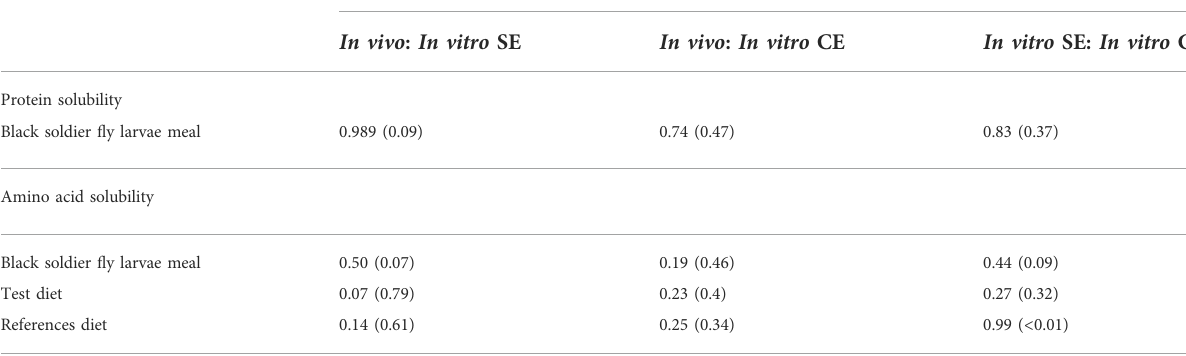
TABLE 5 Correlation between In vivo , and in vitro protein and amino acid solubility of black soldier fl y (BSF) larvae meal, test diet and reference diet using salmon enzymes, and commercial